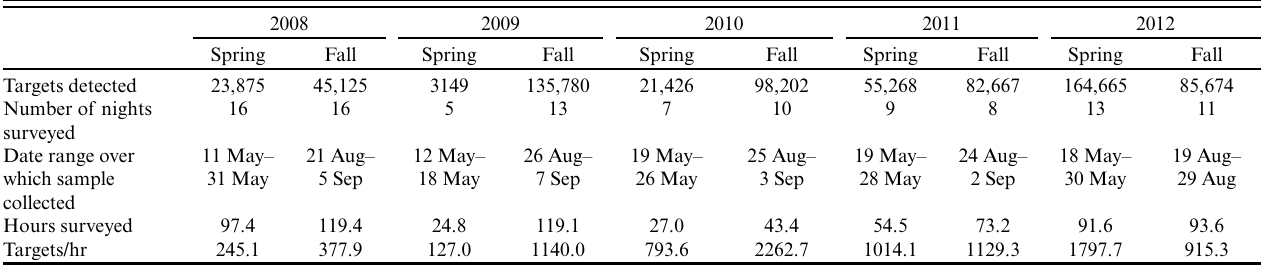
Table 2 . The total numbers of tracked avian targets detected by the vertical radar, by season and year, across the survey period from 2008–2012 at the Dokie I Wind Energy Project in northeast British Columbia. Variation in the number of nights surveyed between season and years reflected both problems encountered with weather and equipment. Target numbers shown reflect exclusion of nonavian targets through application of filter expressions in radR.